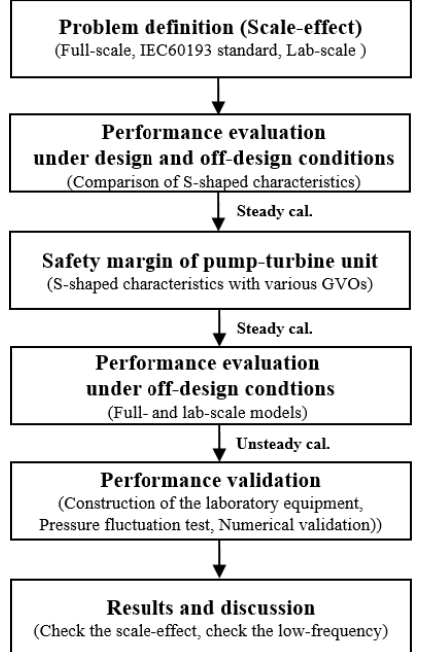
Figure 2. Procedure for analyzing the performance characteristics of model scales.